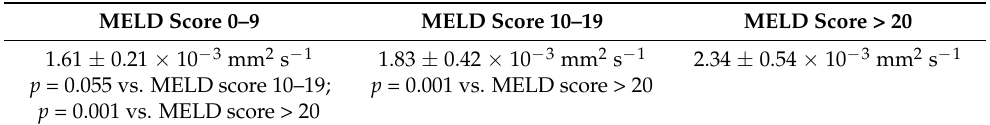
Figure 4. Associations between apparent diffusion coefficient values and the Model for End Stage-Liver Disease (MELD) score. The calculated correlation coefficient is 0.473, p = 0.0001. Table 1. Comparison of apparent diffusion coefficient (ADC) values in dependency of Model for End Stage-Liver Disease (MELD)